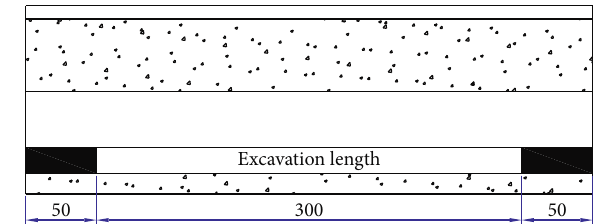
Figure 7: Excavation model.